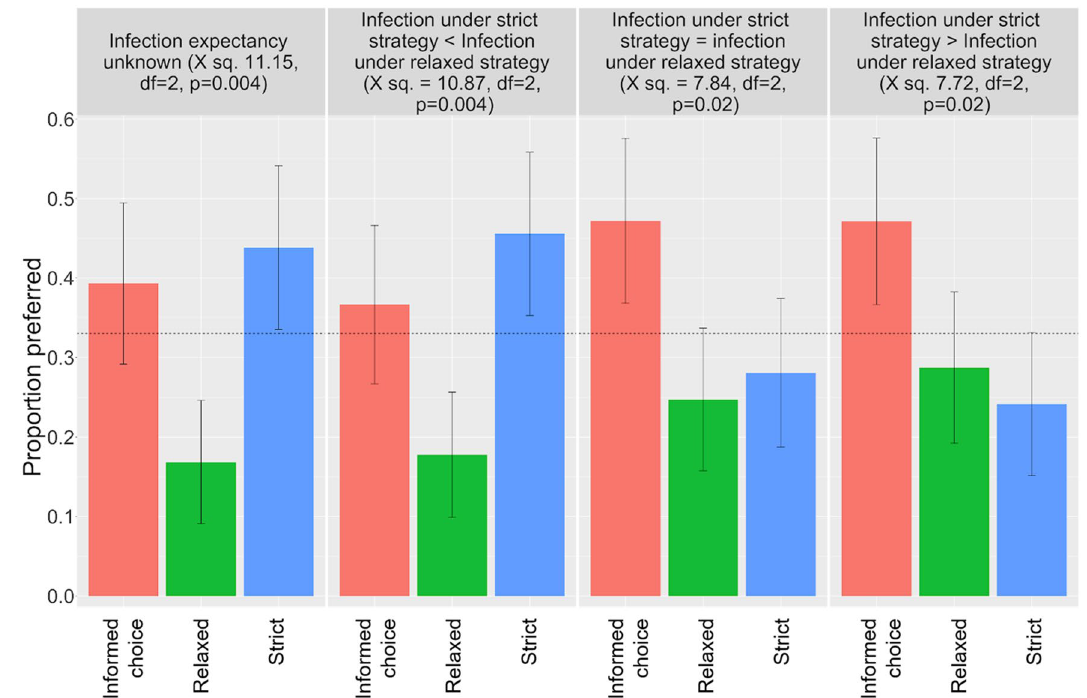
Figure 2. Study 2 results: Proportions of people who preferred each type of advice strategy under various infection expectancy conditions; dashed line: indifference rate (random choice between 3 options); error bars: 95% confidence